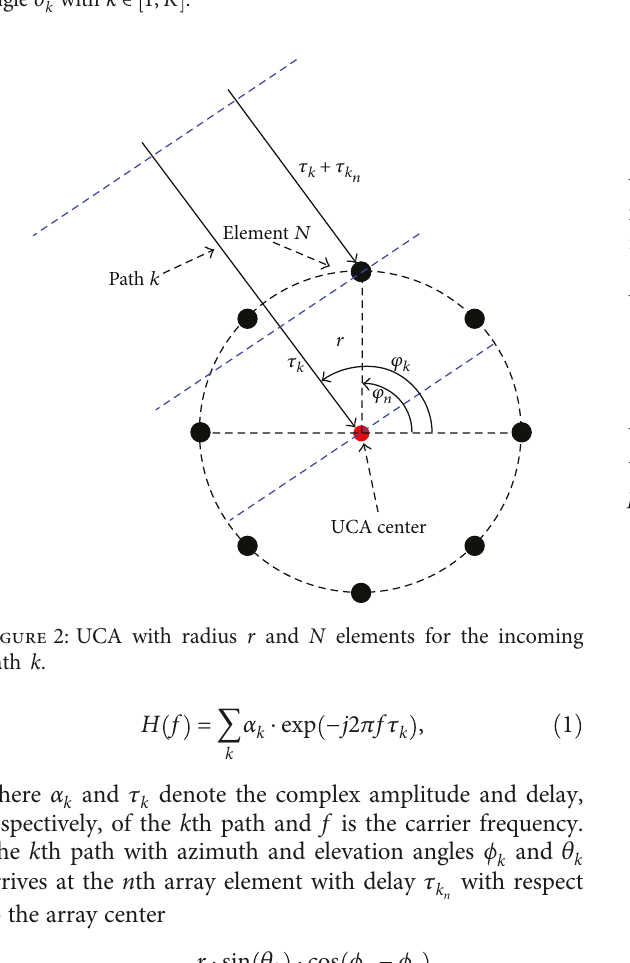
, azimuth angle ϕ and elevation k k